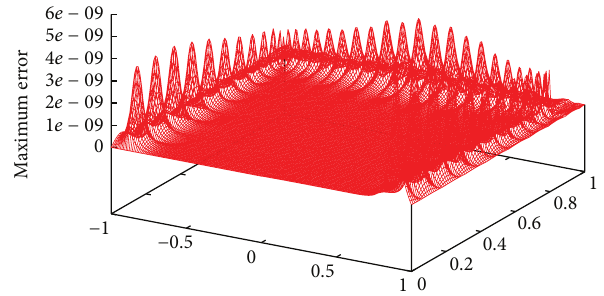
Figure 5: Maximum error plot when local approximation functions havepolynomialreproducingorder8forthe38surroundingpatches and 40 singular basis functions are used on enriched